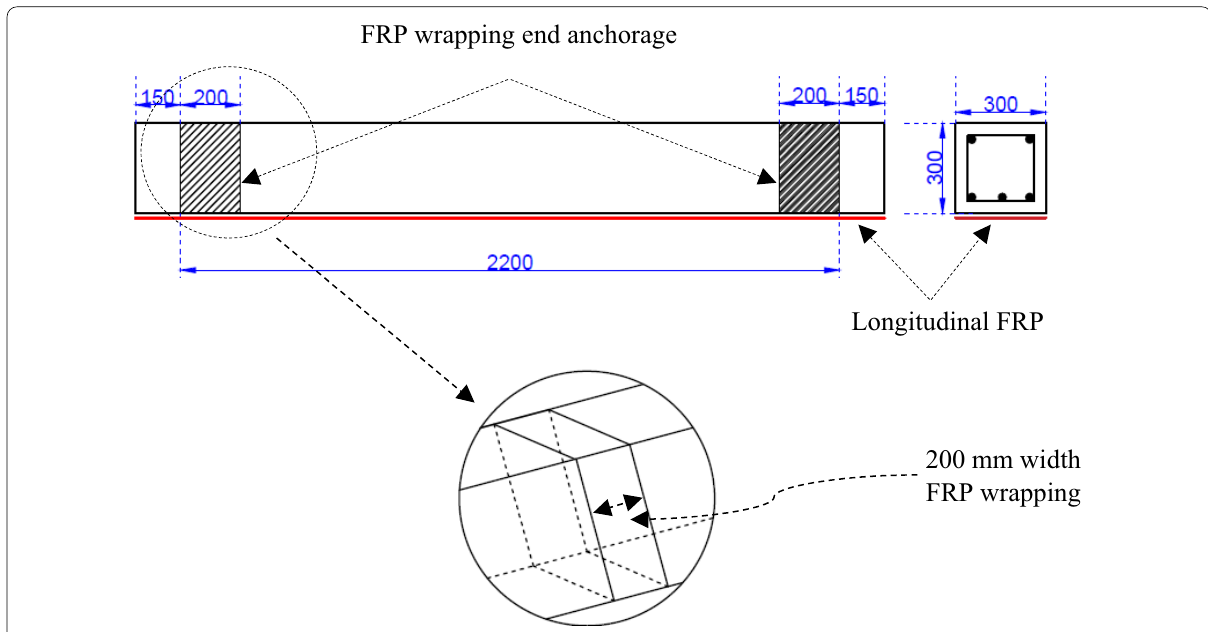
Fig. 3 Details of RCFRP and RGFRP specimens (dimensions in mm).